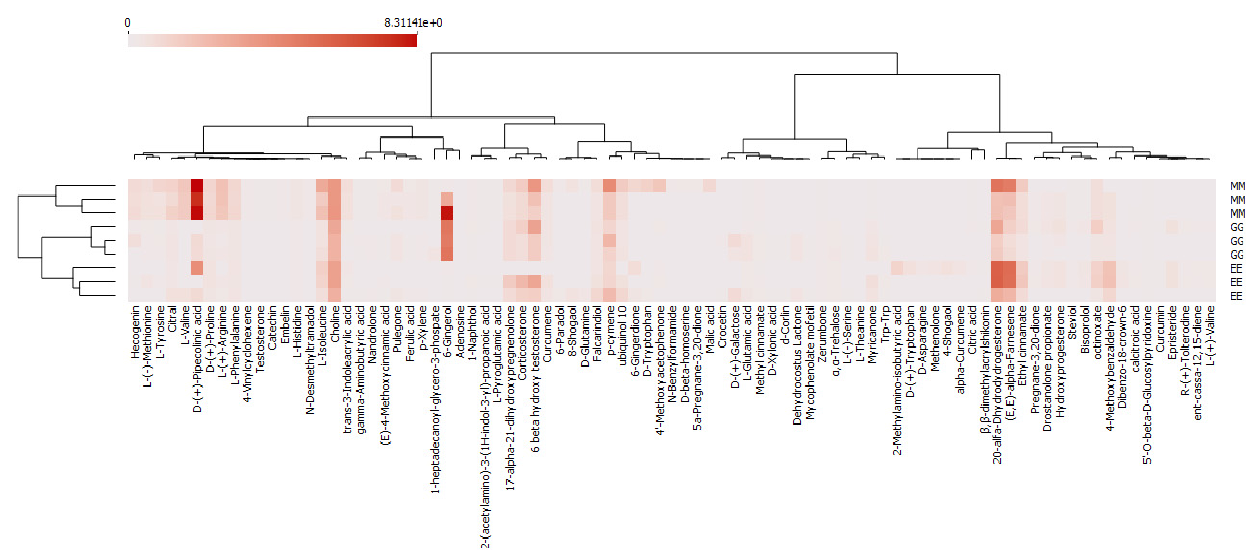
Figure 3. Heat map of LC–MS/MS metabolite profile of Indonesian ginger rhizome extracts.